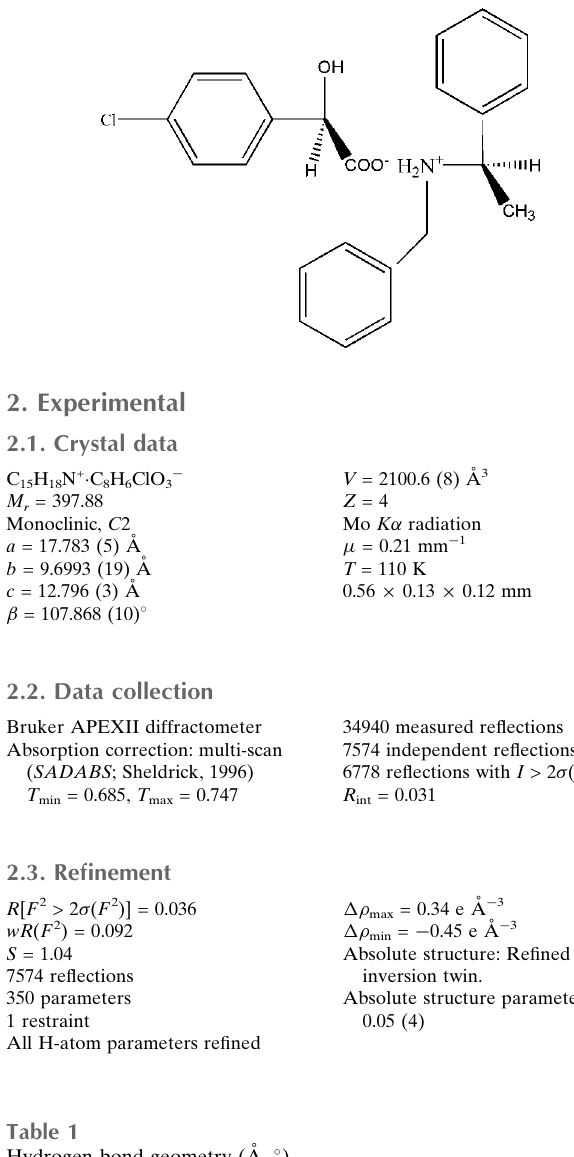
Hydrogen-bond geometry (A˚ , (cid:4) ). Cg 1 and Cg 2 are the centroids of rings C1 B –C6 B and C10 B –C15 B ,